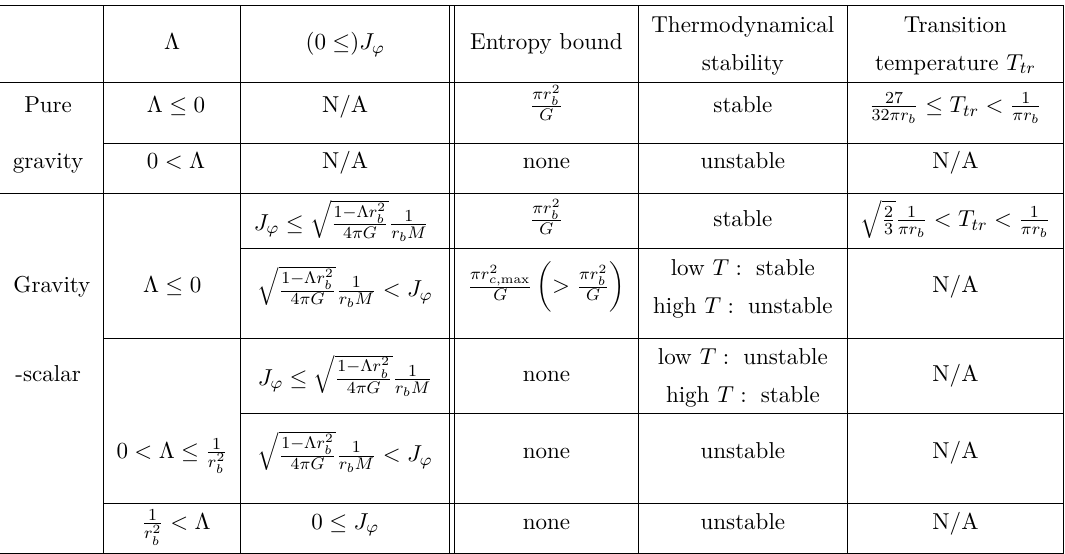
Table 1 . Summary of thermodynamical properties of pure gravity system and gravity-scalar sys- tem. The definitions of J somewhere in section 4. Note that, by symmetry, we can restrict J